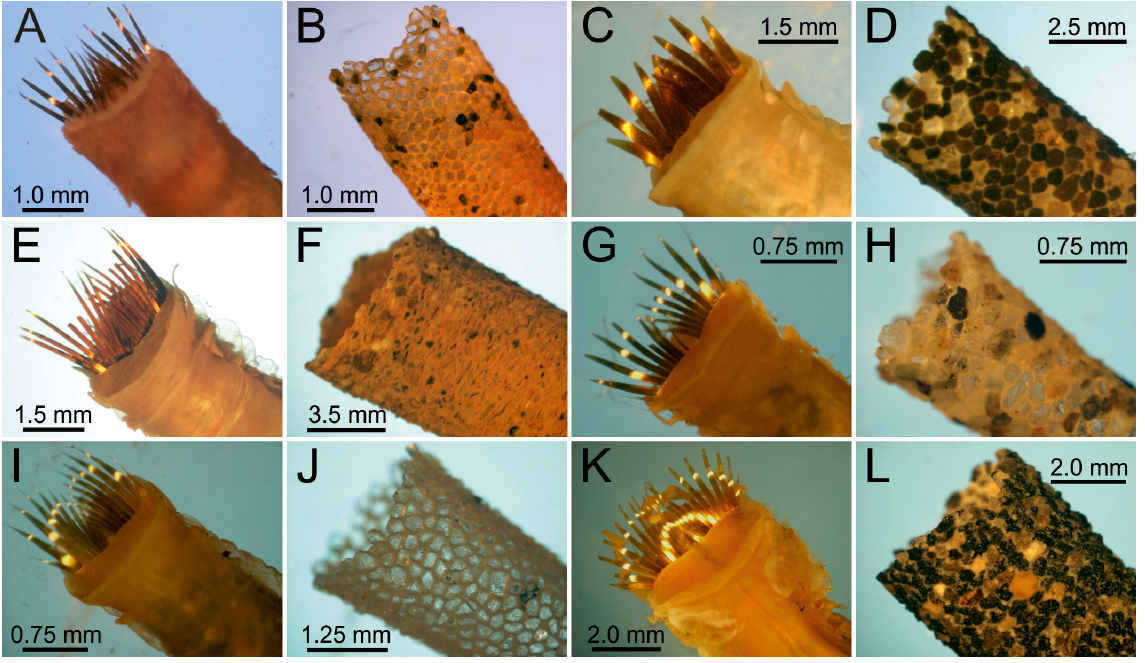
Fig. 4. Stereomicrographs of anterior body ends (dorsal view) and anterior end of the tube. A–B . Amphictene auricoma (O.F. Müller, 1776) (BIOICE sample 2946, IINH-40181). C–D .